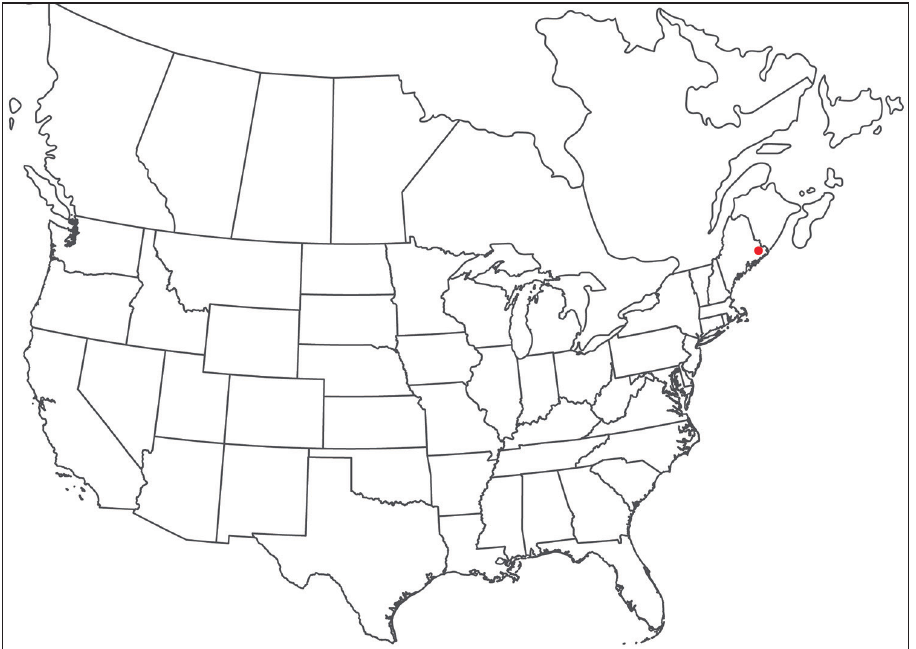
Figure 187. Torrenticola pendula sp. n.